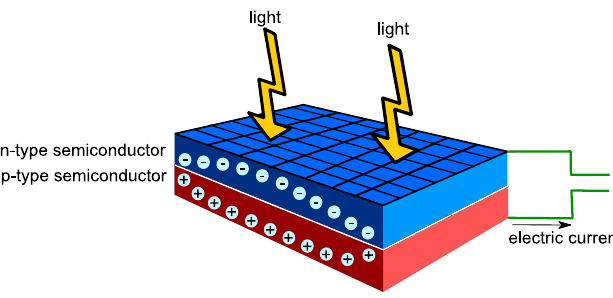
Figure 3. Photovoltaic harvester.